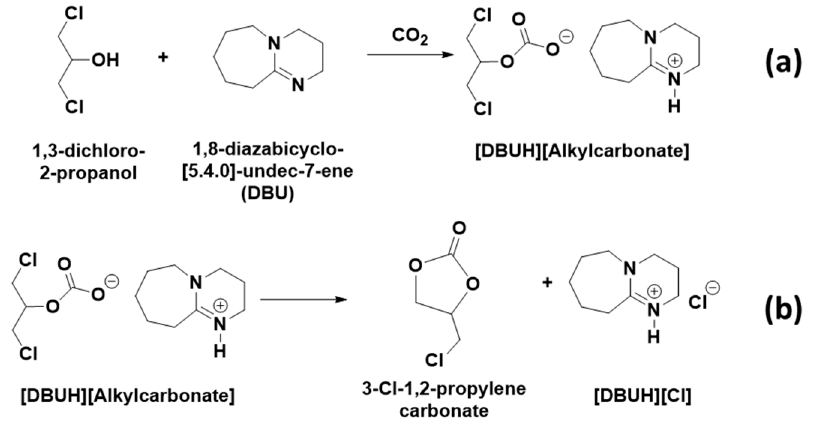
Scheme 3 . ( a ) Activation of CO 2 by DBU through proton abstraction from 1,3-dichloro-2-propanol and ( b ) formation of 3-chloro-1,2-propylenecarbonate and [DBUH][Cl] salt.